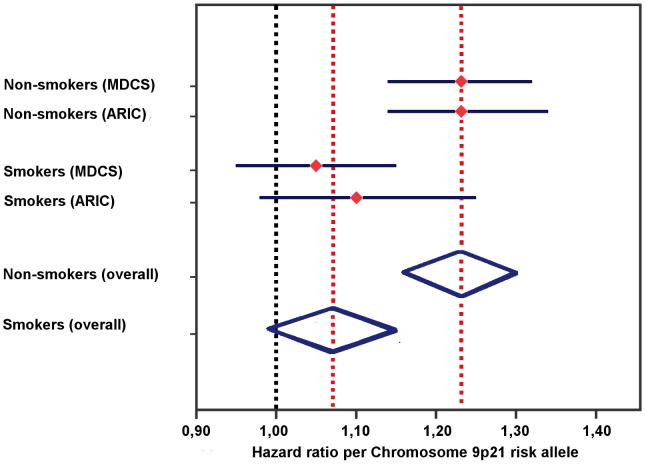
Meta analysis: Risk of incident CAD by Chromosome 9p21 stratified by smoking status.Hazard ratios (HR) with 95% Confidence Interval (CI) per Chromosome 9p21 risk allele in MDCS (rs4977574; N = 24944; 28% smokers) and ARIC (rs10757274; N = 9877; 25% smokers). Pooled HR per allele for incident CAD in non-smokers and smokers were 1.23 (95% CI 1.16–1.30) and 1.07 (95% CI 0.99–1.15) respectively. MDCS  =  Malmö diet and cancer study. ARIC  =  Atherosclerosis Risk in Communities Study.